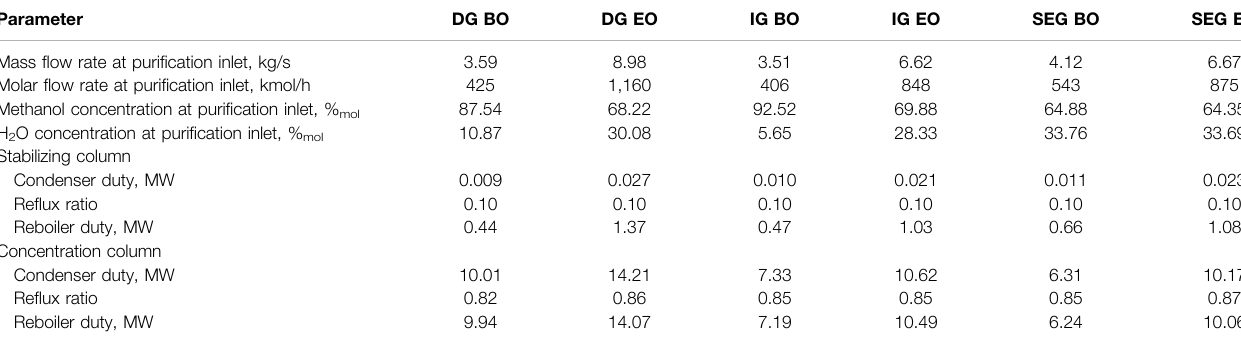
TABLE 5 | Characteristics of the raw methanol streams fed to the puri fi cation section for the assessed cases. Methanol puri fi cation operating conditions. Parameter DG BO